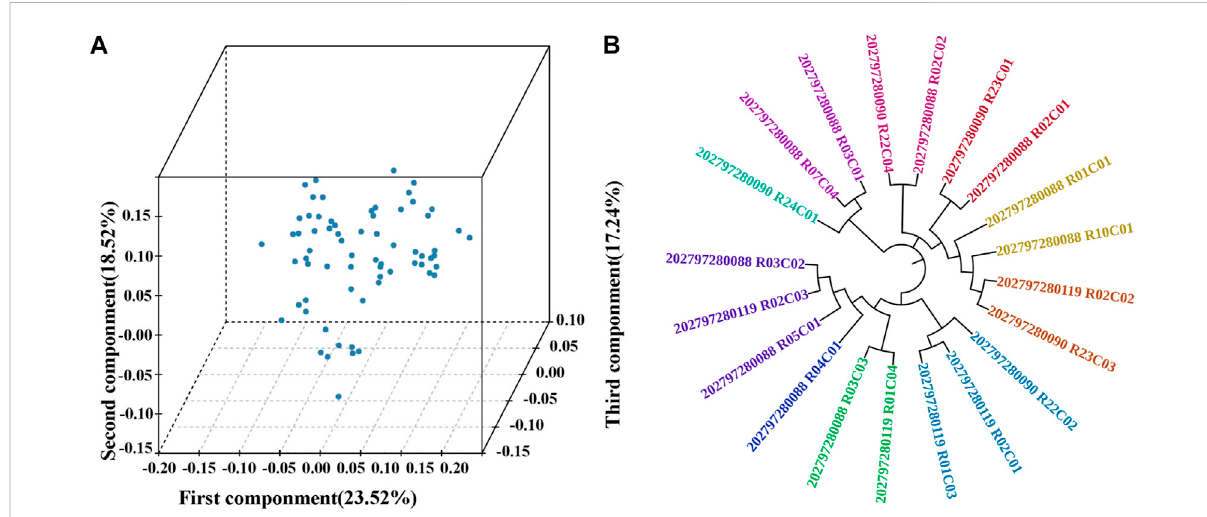
FIGURE 1 Population structure of Tongcheng (TC) pigs. (A) Multi-dimensional scaling analysis of TC pigs. The fi rst three components ( fi rst component, second component and third component) were analyzed. (B) Phylogenetic relationships (unrooted NJ-tree) between 20 TC boars. 20 boars were divided into 10 families, and individuals with the same color represent one family, while different colors are different